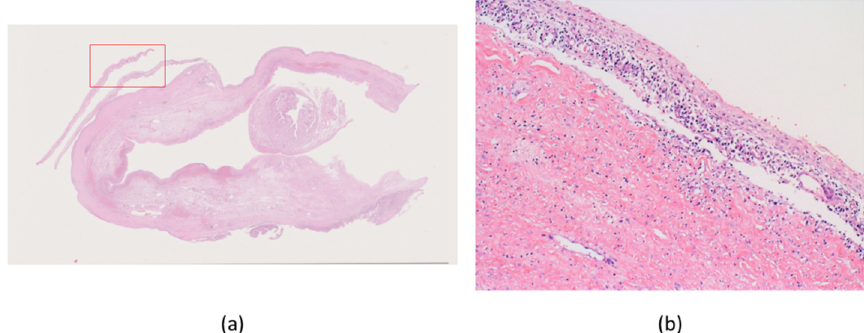
Figure 3. A mature cystic teratoma was observed in a small sac, containing squamous epithelium (low-power: ( a : 0.4 × ), high-power: ( b : 5 × )) (H&E staining).